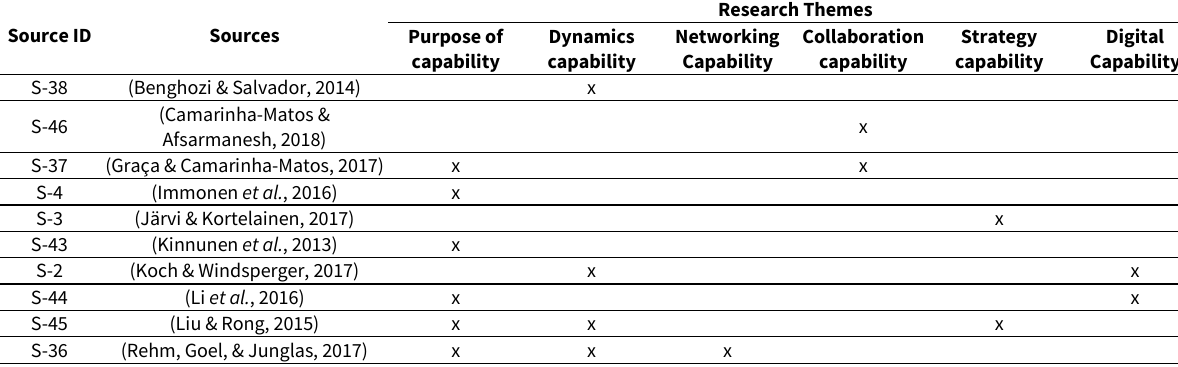
Table 7. Capabilities required by organisations in